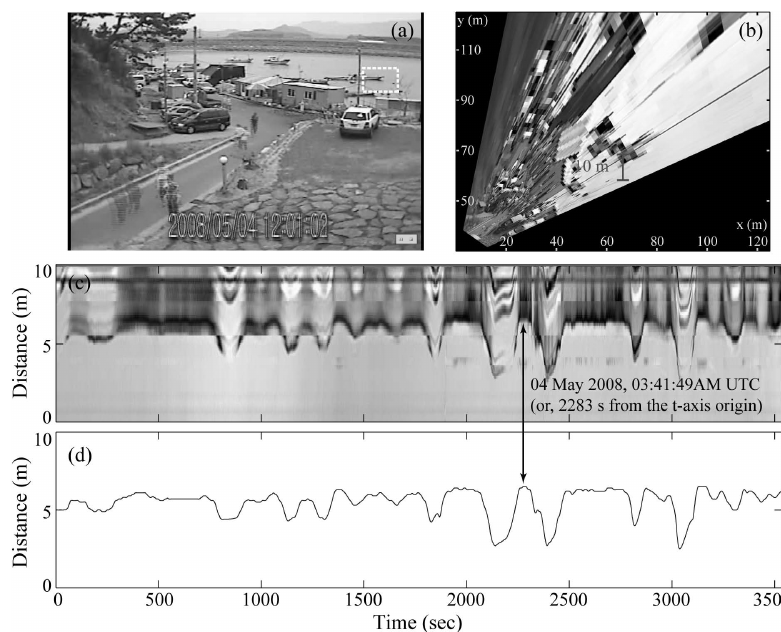
Fig. 5. (a) A boat used to measure horizontal sea-level oscillations in the third video view sector, (b) a image pixel array to track the horizontal movements of the boat in (a) in time sequence, (c) image timestack generated along the 10m-long transect in (b) from the third video data burst, (d) time-series of horizontal sea-level oscillations extracted from the image timestack in (c) by means of the Canny edge detection